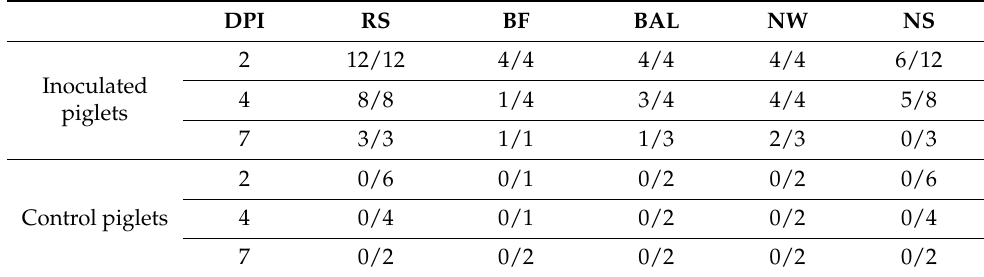
Viral RNA (with titers above the LoD of 3.6 log 10 GE/mL) was detected in 4/4, 1/4, and 1/1 BF samples from inoculated piglets at 2, 4, and 7 DPI, respectively (Table 1). In total, 13 BF samples were tested; the remaining piglets were not tested due to either early euthanasia (piglet no. 10), or too little or too dry biliary contents to allow sampling and RNA extraction. The mean ( ± SD) titers in BF samples from inoculated piglets were 5.3 ( ± 0.4) log 10 GE/mL at 2 DPI, 3.9 ( ± 0.6) log 10 GE/mL at 4 DPI, and 4.5 log 10 GE/mL